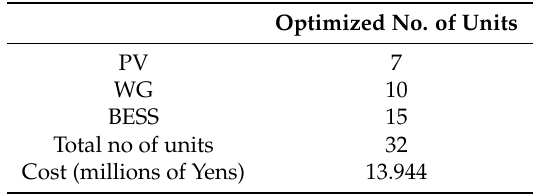
Figure 6. scenario 1 results. Table 2. Scenario 1